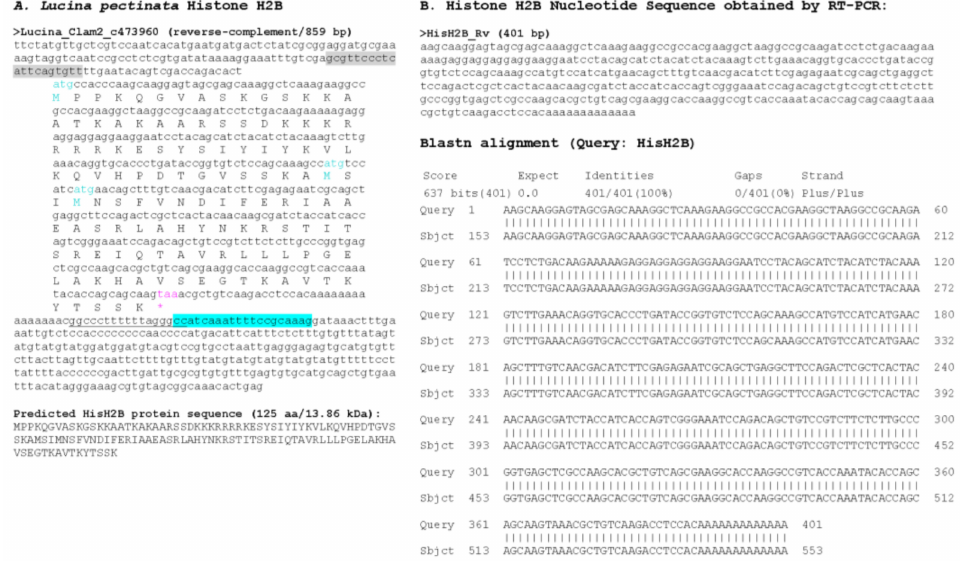
Figure 6. Histone H2B sequence found in Lucina pectinata genome assembly. ( A ) Histone H2B nucleotide sequence obtained from the BLASTN searches against the L. pectinata genome assembly using the H2B nucleotide sequence from S. marginatus is shown, including the coding region, the predicted protein sequence and its molecular weight (MW). ( B ) The nucleotide sequence obtained by Sanger sequencing of RT-PCR products followed by the BLASTN alignment of the cDNA to the genomic sequence, showing a perfect match between the two sequences. Primers used in RT-PCR are highlighted in cyan and grey. Start (cyan) and stop (pink) codons are